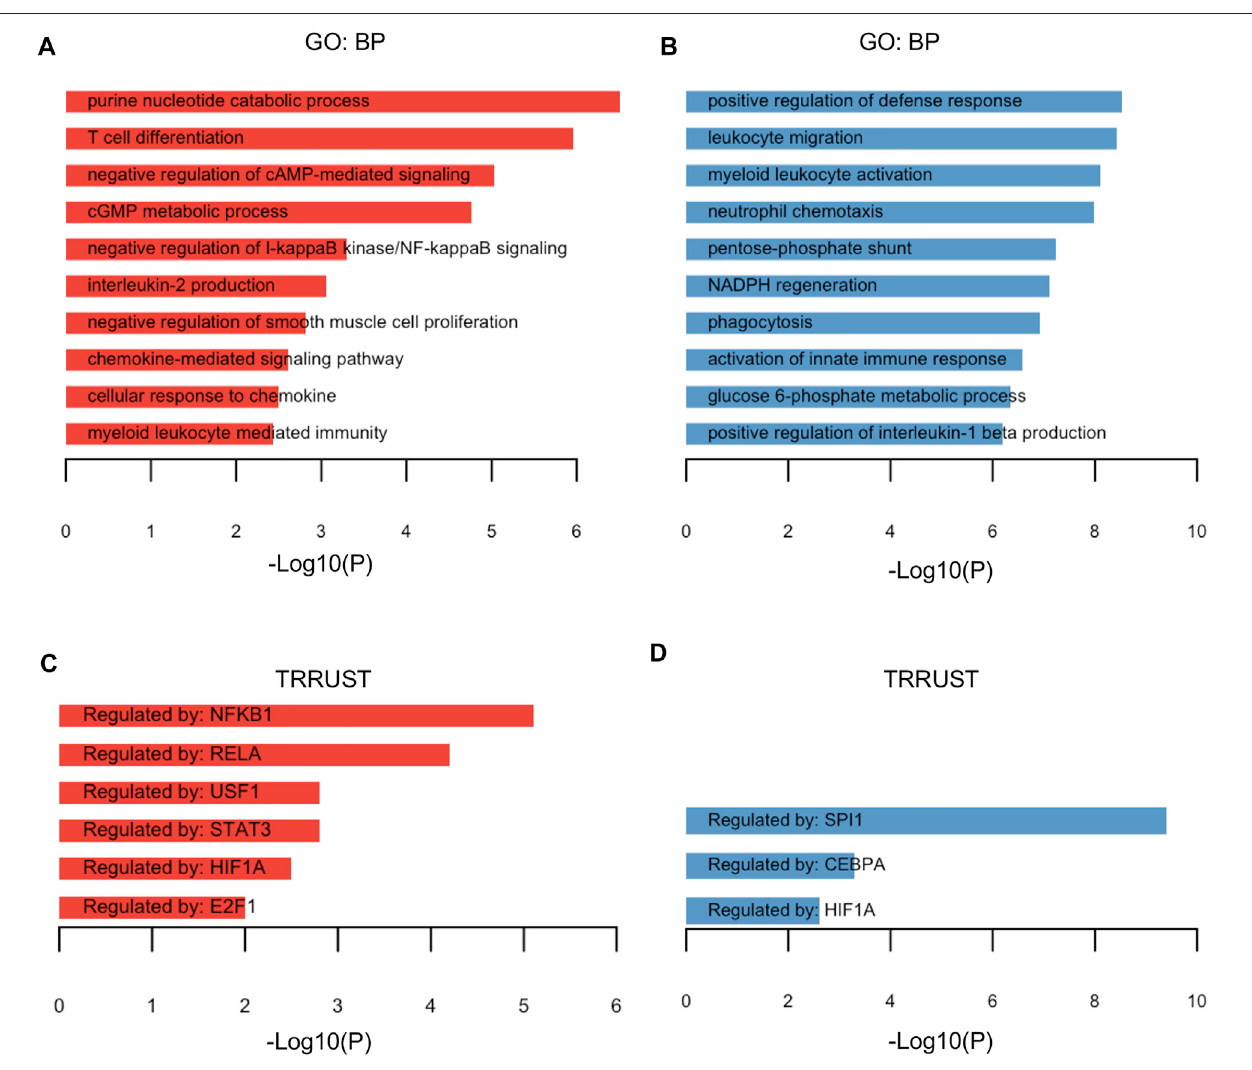
FIGURE 2 | Functional annotation of TRGs. (A,B) Gene Ontology — biological pathways for 90 upregulated TRGs (A) and 75 downregulated TRGs (B) of the aforementioned dataset were identi fi ed by the functional annotation web tool DAVID and visualized in the barplot. (C,D) Genes encoding transcriptional factors in regulation of the gene pro fi ling of upregulated TRGs (C) and downregulated TRGs (D) were explored and identi fi ed by the TRRUST category from the functional annotation tool Metascape.